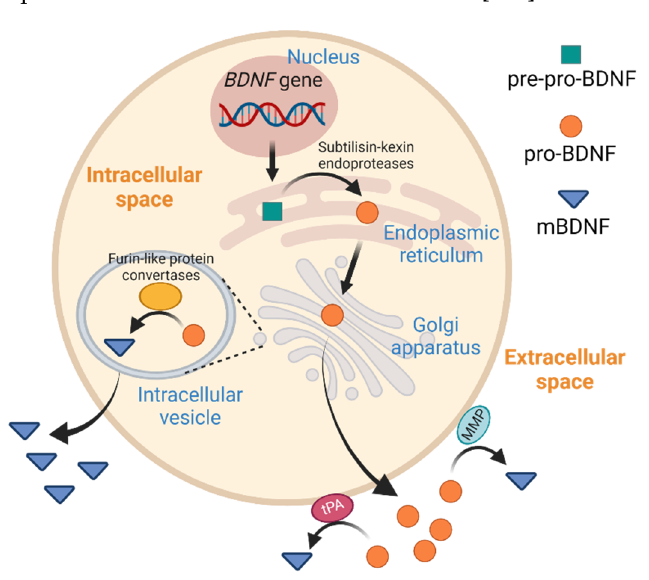
Figure 1. Synthesis of pro-BDNF and mature BDNF (mBDNF). BDNF mRNA is translated in the endoplasmic reticulum to form pre-pro-BDNF, which is subsequently cleaved to form pro-BDNF. After being transported into the Golgi apparatus, the pro-BDNF is further converted into mBDNF by furin-like protein convertases. Alternatively, pro-BDNF is exported as a functional hormone or is further processed by the tissue type plasminogen activator (tPA) or matrix metalloproteinase (MMP) to form mBDNF